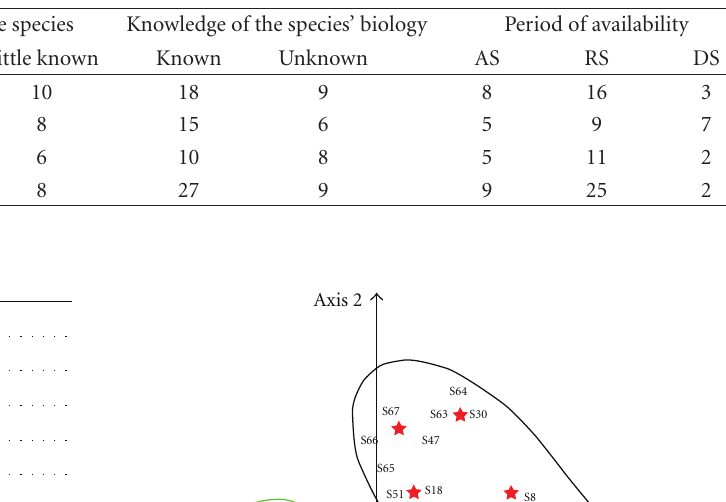
Table 3: Knowledge of the species and of their biology by the local communities.